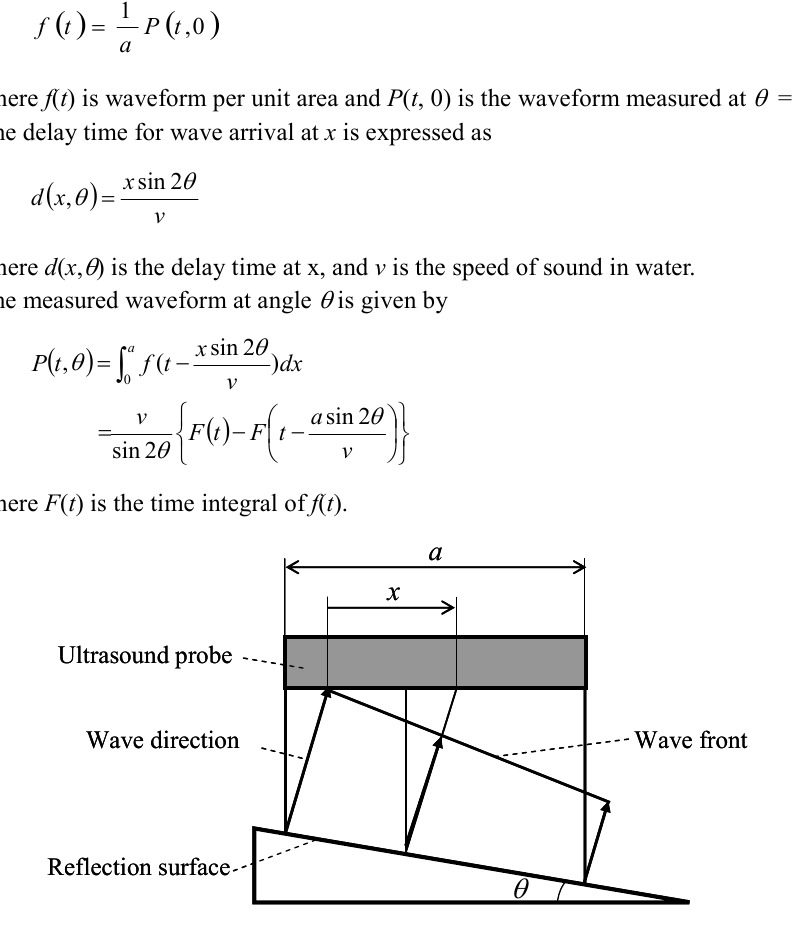
where f ( t ) is waveform per unit area and P ( t , 0) is the waveform measured at θ = 0. The delay time for wave arrival at x is expressed as